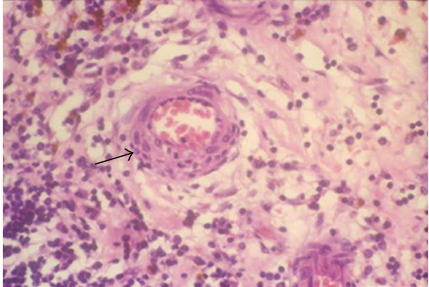
Figure 1: Histopathological image of a retinal blood vessel involved in Behc¸et’s disease (H & E stain). Note the perivascular infiltration of lymphocytes around the vessel